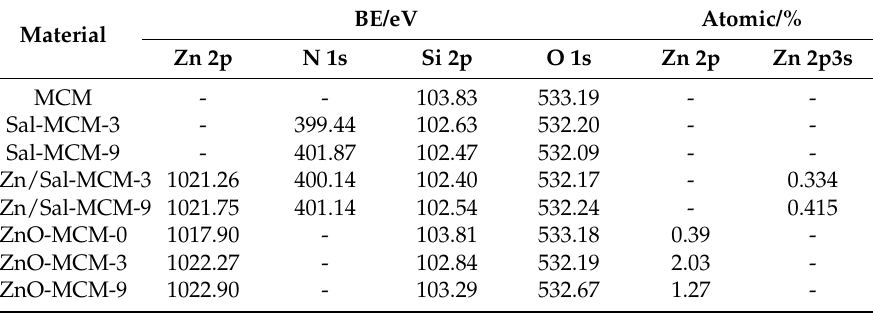
Figure 6. X-ray photo electron spectroscopy (XPS) of Zn 2p ( a ); N 1s ( b ); O 1s ( c ); Si 2p ( d ); survey ( e , f ) ofMCM-41, Sal-MCM, and ZnO-MCM. Table 3. Binding energy and atomic of MCM-41, Sal-MCM, Zn/Sal-MCM, and